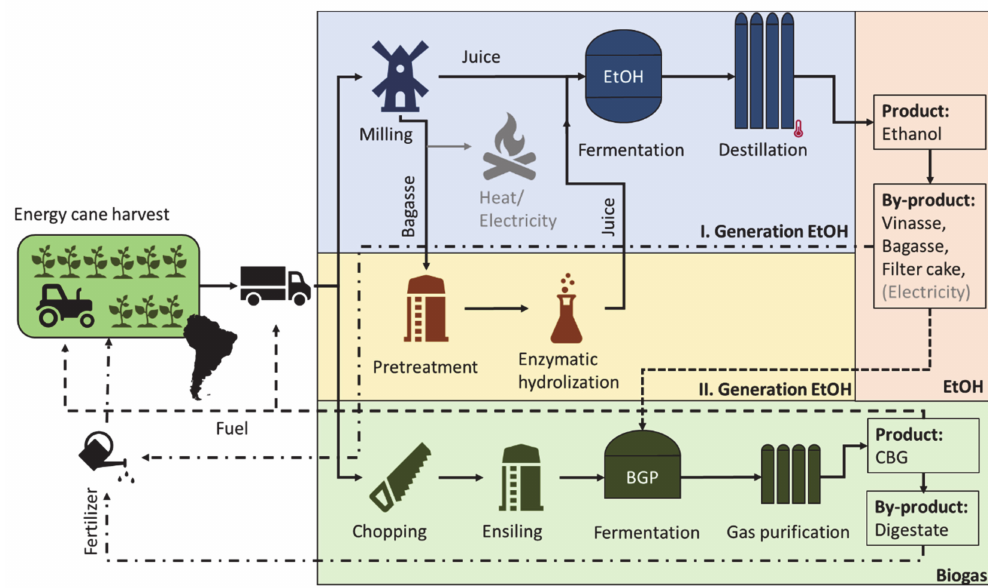
Figure 5. Production schemes of compressed biogas (CBG) from biogas plants (BGP) and first- and second-generation ethanol